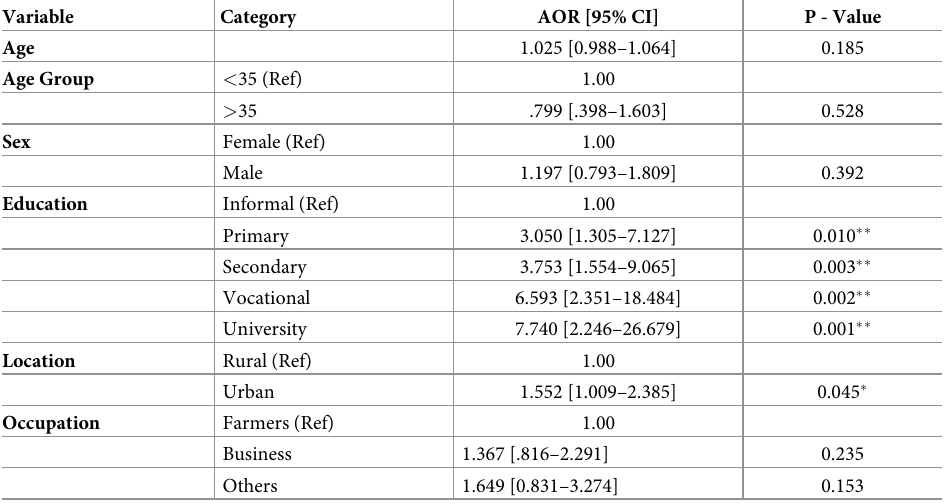
Table 4. Binary logistic regression analysis showing social demographic characteristics that affect consumer’s